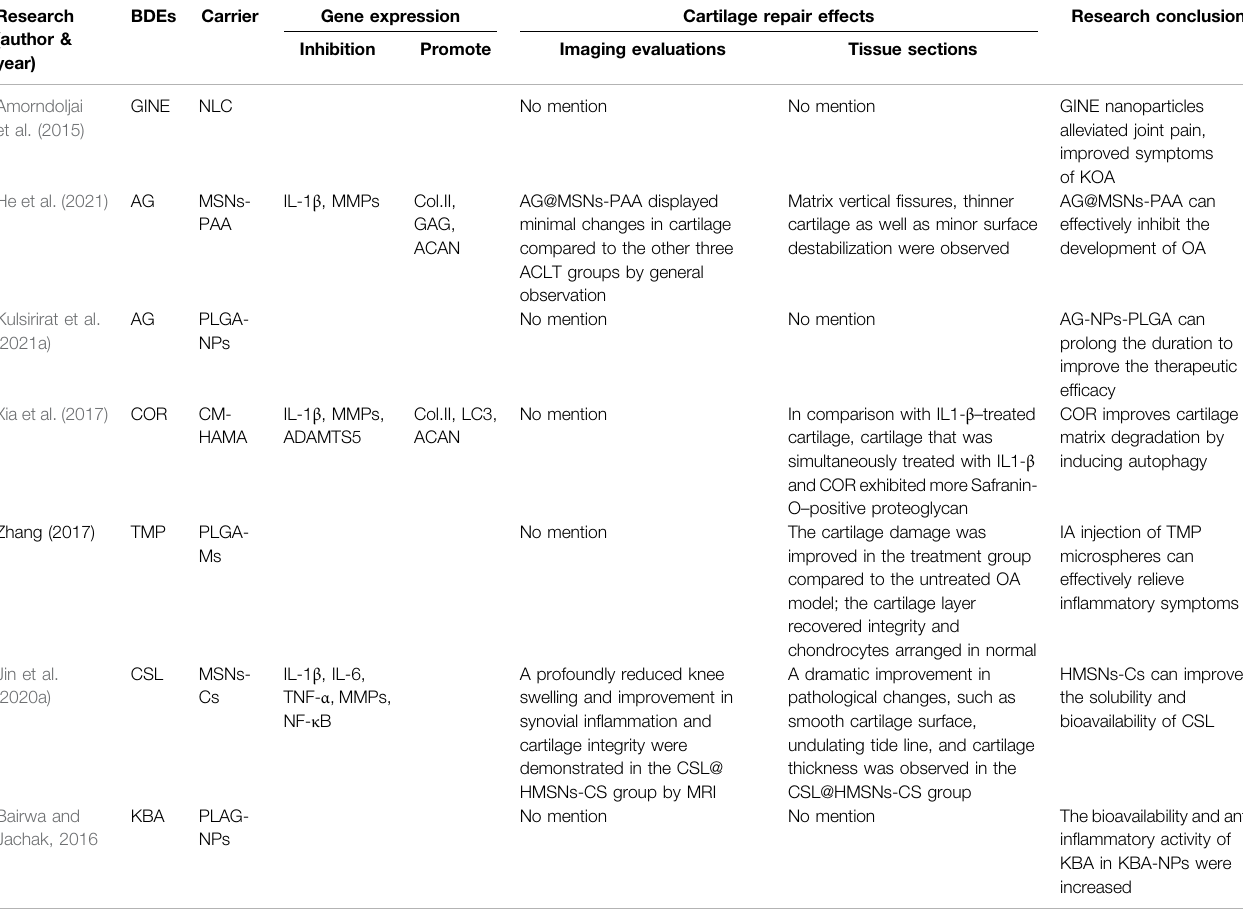
TABLE 5 | The effect of other effective components of traditional Chinese medicine combined with carriers on OA cartilage